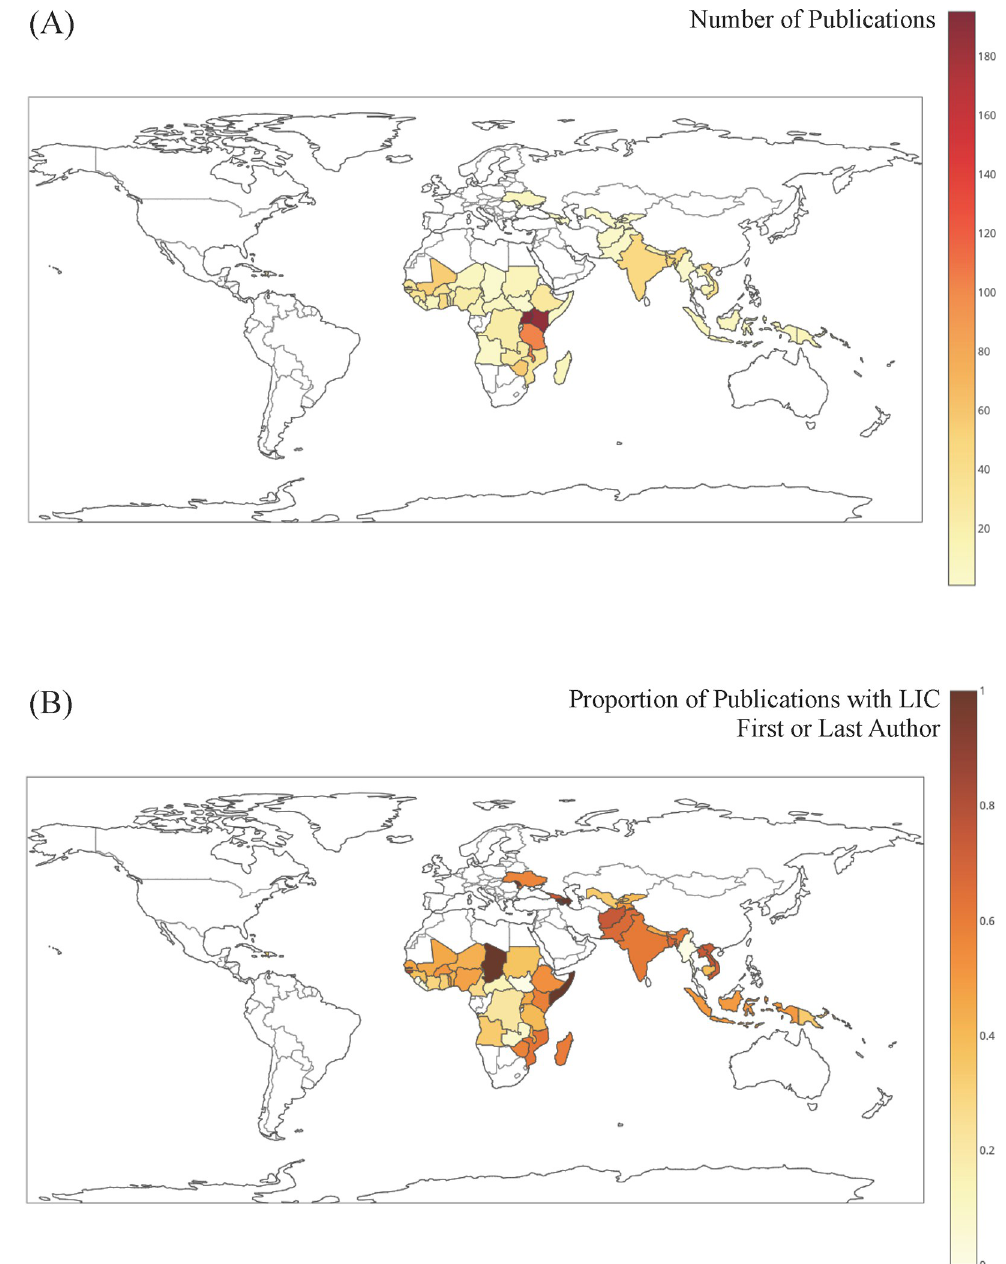
Fig 4. Geographic distribution of LIC publications. (A) Total number of publications between 1998–2017 and (B) by proportion of publications with LIC-affiliated first or last authorship. Maps were created using Plotly Chart Studio (Plotly Technologies Inc, released 2015). Abbreviations: LIC, low-income